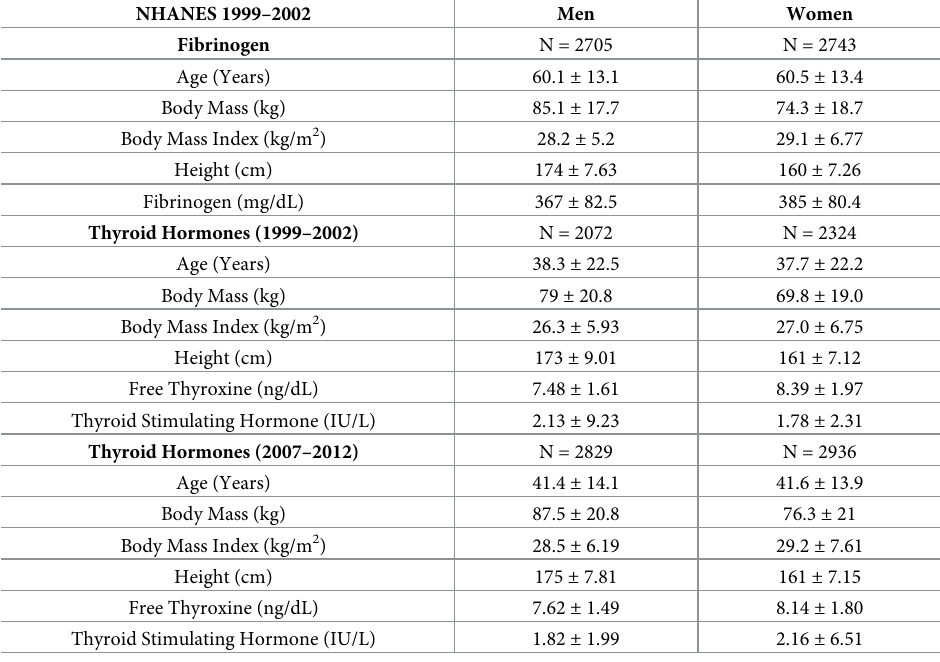
Table 2. Summary statistics for the samples used for the analysis utilizing questionnaire responses.